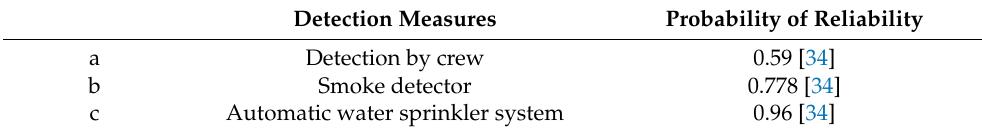
Figure 6. Layout of the engine room. Table 1. Reliability of fire detection facilities.